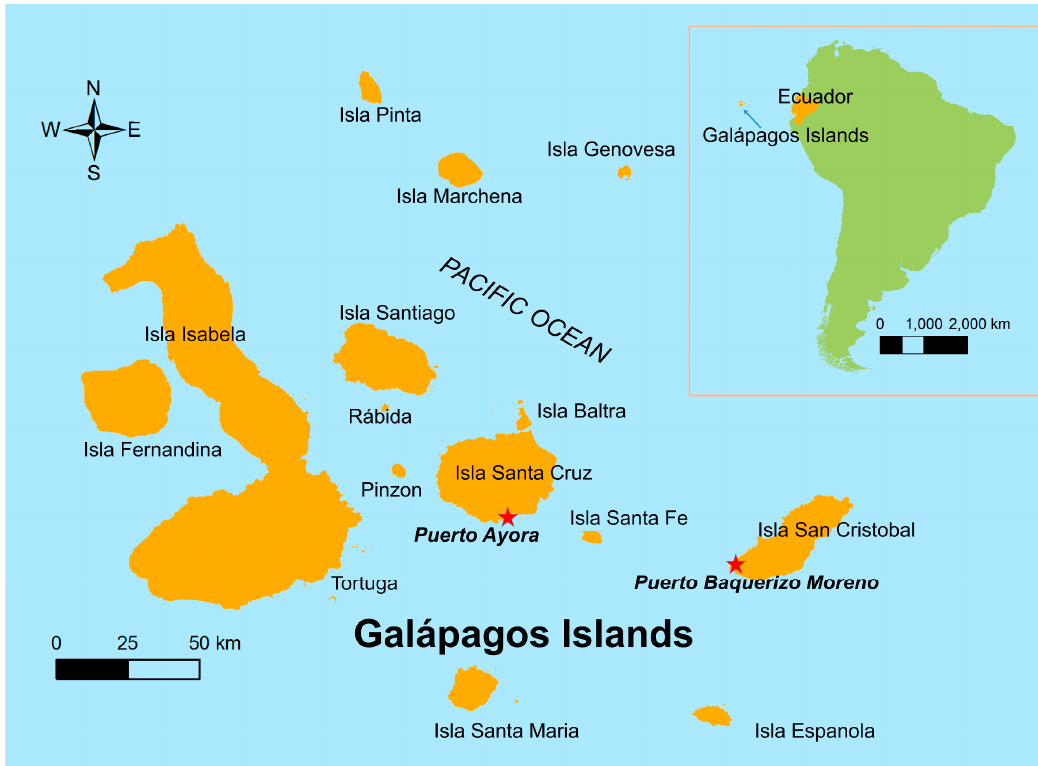
Figure 1. Location of study sites (Puerto Ayora and Puerto Baquerizo, red stars) in the Galápagos Islands, Ecuador.